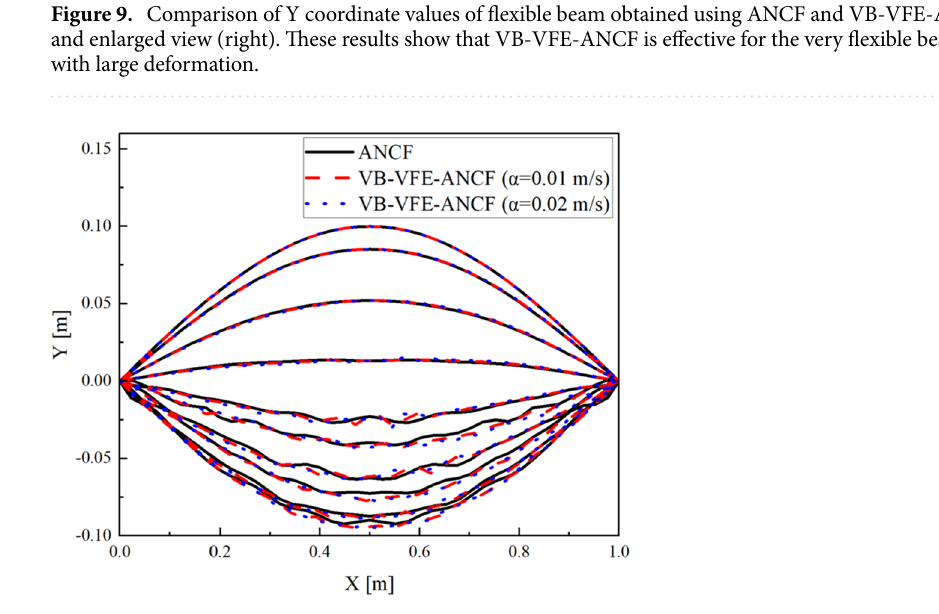
Figure 10. Comparison of the flexible beam shape obtained using ANCF and VB-VFE-ANCF for 1 s every 0.1